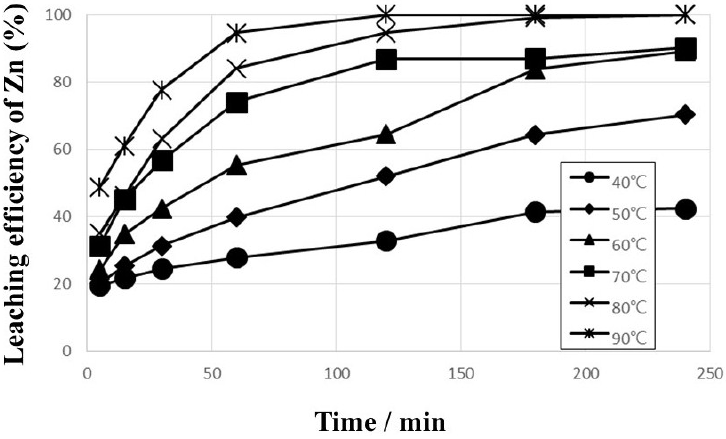
Figure 4. The effects of temperature on the leaching efficiency of Zn at 1 kmol·m −3 HCl with 1 kmol·m −3 Fe 3+ , 10% pulp density, and 400